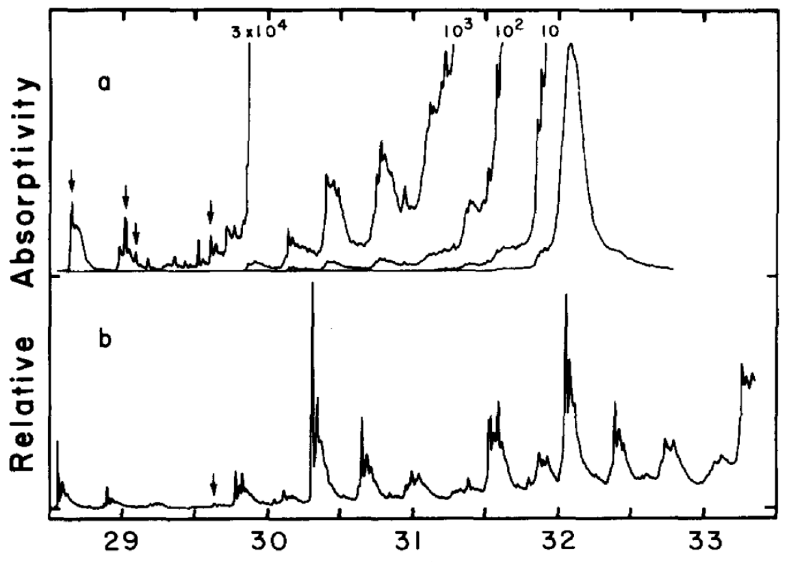
Figure 7 . ( a ) The one ‐ photon fluorescence excitation spectrum of octatetraene in n ‐ octane matrix at 4.2 K. The arrows mark the vibronically induced transitions to the forbidden 2 1 A g excited state. The intense broad feature at 32,200 cm − 1 is the vibration ‐ less origin of the allowed electronic transition to the 1 1 B u excited state; ( b ) Two ‐ photon fluorescence excitation spectrum of the same sample. All of the features are due to transitions to the 2 1 A g excited state. [59,67,68].